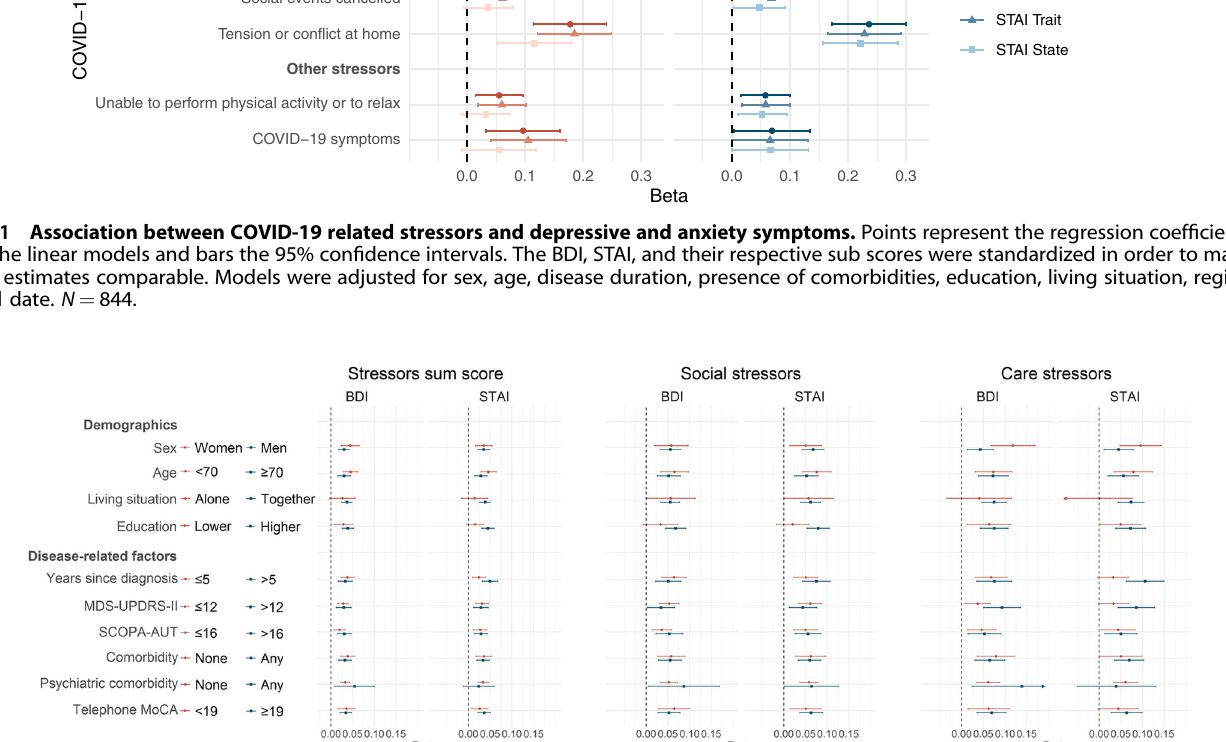
three time strata. Supplementary Fig. 3 shows the main results after excluding participants with psychiatric comorbidities, which are similar to the results shown in Fig. 1. In an additional analysis of the Personalized Parkinson Project (PPP) data, we found an association between the COVID-19 stressor sum score (0 – 25) and pre-COVID-19 BDI (beta: 0.06, 95% CI: 0.03 – 0.08), STAI (beta: 0.05,